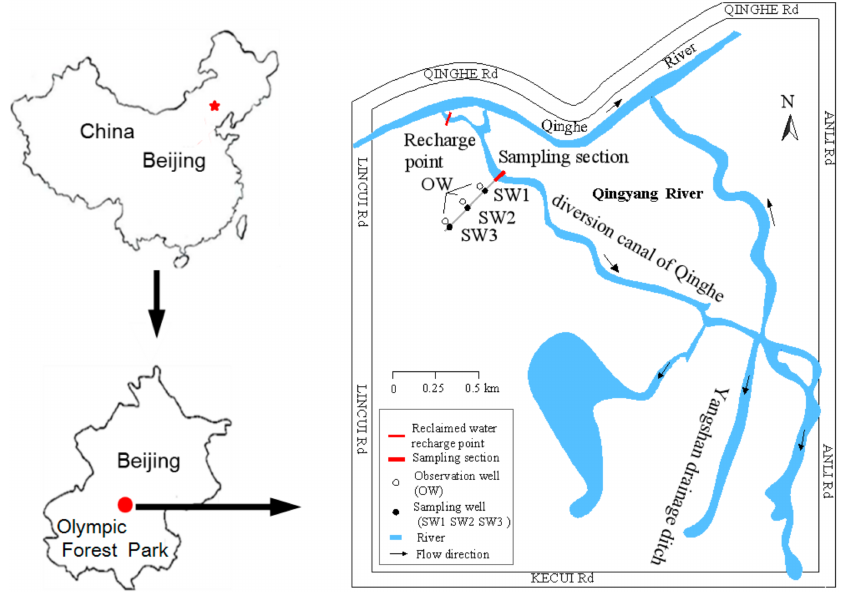
Figure 1. Location of the study site and location of sampling points.